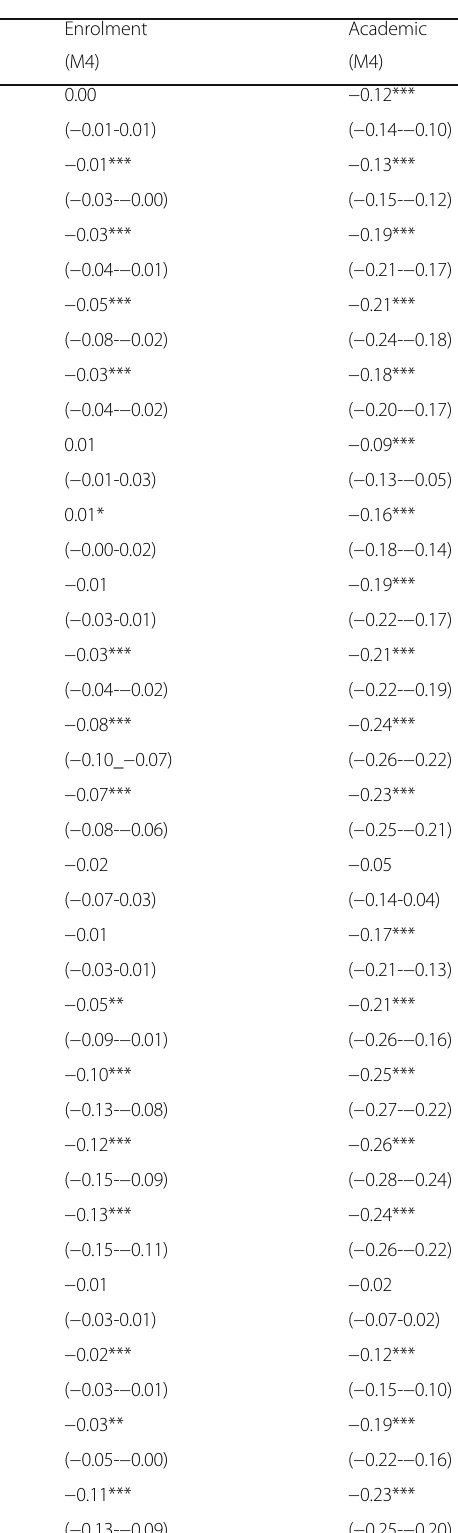
Table 1 Beta coefficients (with 95% c.i.) of control variables from Figs. 1 and 2 (model